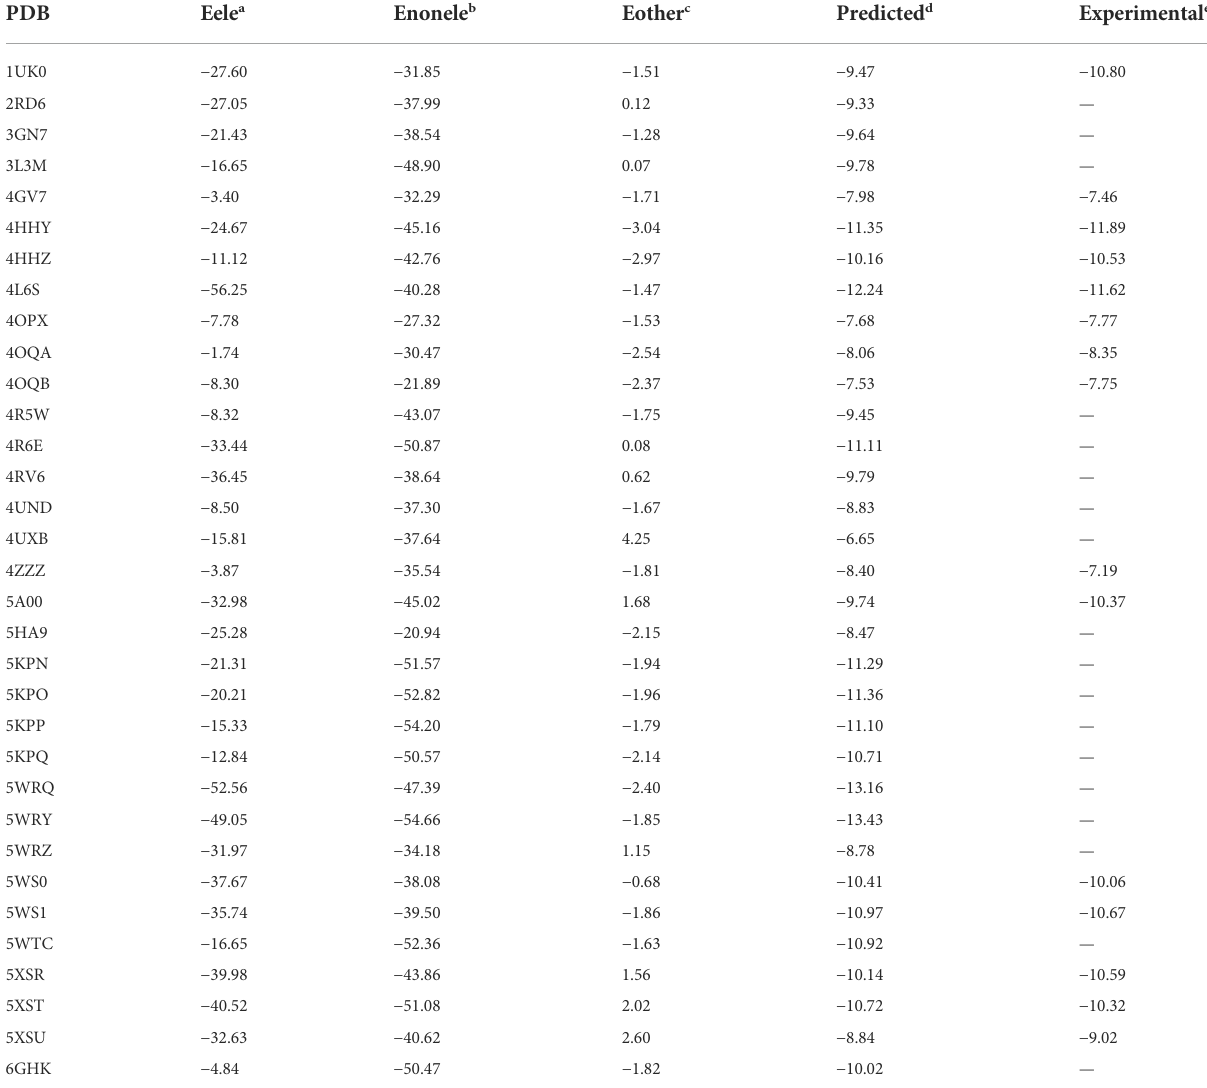
TABLE 1 The calculated energy contribution of three residue groups and the predicted activities by a multiple linear regression model. PDB Eele a Enonele b Eother c Predicted